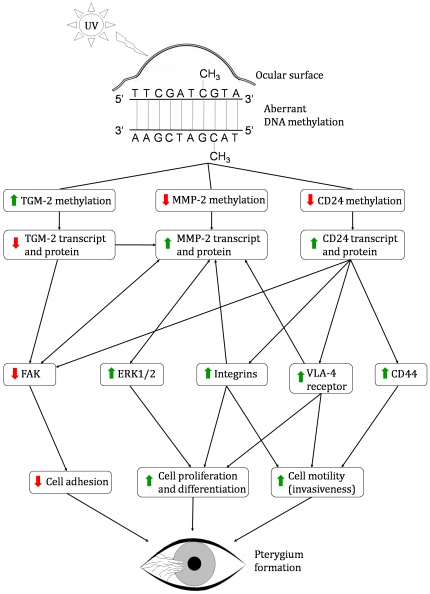
Pterygium pathogenesis.Environmental factors, such as UV exposure, have been known to trigger changes in DNA methylation. UV has also been strongly associated with pterygium formation. This may suggest a mechanism whereby UV can trigger tissue and temporal specific changes in matrix remodeling and cell adhesion related genes, such as transglutaminase 2 (TGM-2), matrix metalloproteinase 2 (MMP-2), and CD24 to initiate pterygium formation. ERK1/2, FAK and VLA-4 are the abbreviations of extracellular signal-regulated kinase 1/2, focal adhesion kinase and very late antigen-4, respectively.